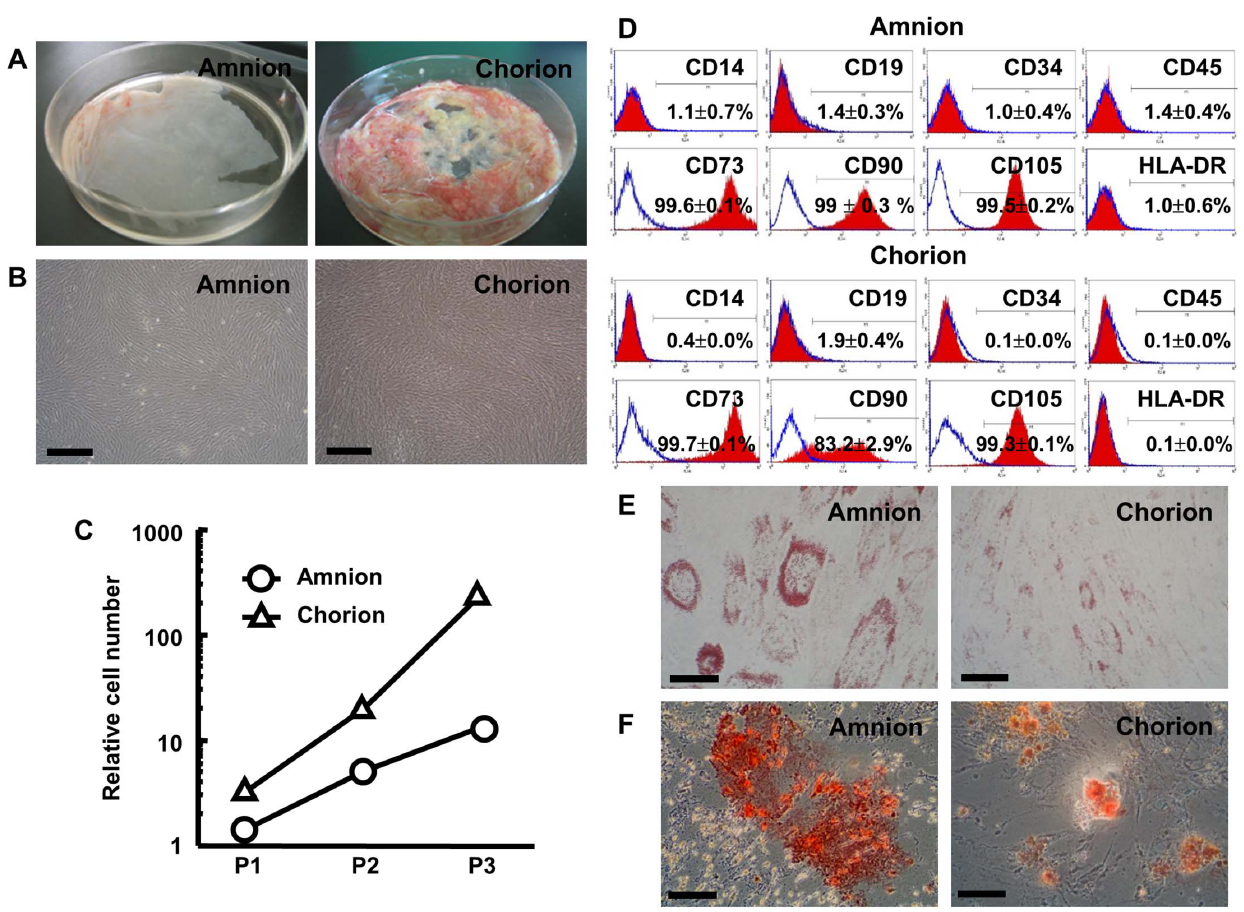
Figure 1. Characterization of human amnion- and chorion-derived MSCs. (A) Representative photographs of human amnion and chorion. (B) Photographs of cultured MSCs obtained from human amnion and chorion at passage 3. Scale bars=500 m m. (C) Relative cell number of amnion- and chorion-derived MSCs at each passage. (D) FACS analysis of amnion and chorion MSCs. (E, F) Differentiation of amnion and chorion MSCs into adipocytes (E) and osteocytes (F). Scale bars=100 (E) and 50 (F) m